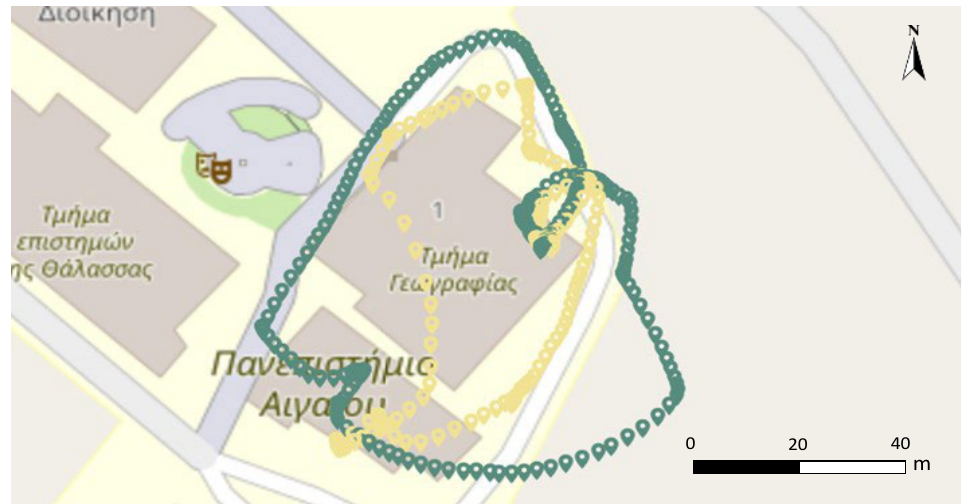
Figure 16. Two trajectories depicted with different colors (green for trajectory A, yellow for trajectory B), intersecting at several points.